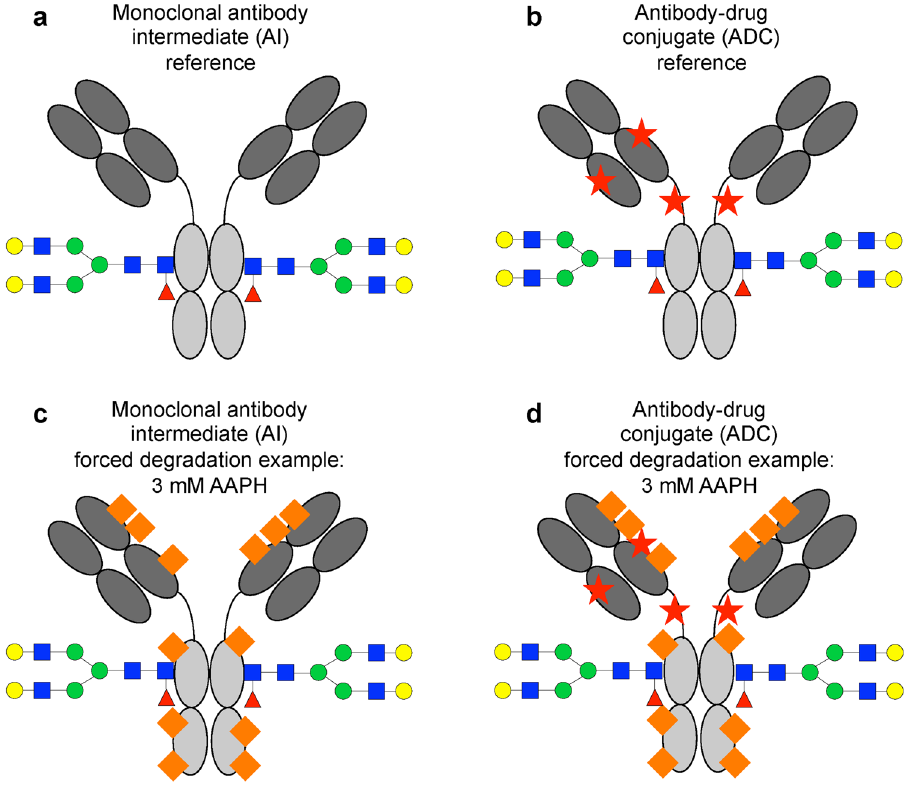
Figure 1. Overall experimental design. ( a ) Schematic representation of a reference antibody intermediate (AI) sample (gray), and its modifications such as N-linked glycosylation (colors). ( b ) Schematic representation of a reference antibody drug conjugate (ADC). The ADC is an immunoglobulin G1-kappa monomethylauristatin E (MMAE) conjugate, where one or more of the inter-chain disulfide bridges of the AI were intentionally chemically modified to an average of three to four linker-drug-modified cysteine residues (red stars). The conjugation was not expected to impact post-translational modifications of the AI. More than 34 post- translational modifications were considered herein, and enriched minor variant samples were generated for some modifications. ( c ) Schematic representation of one of the forced degradation conditions (e.g., 3 mM AAPH) applied to AI. The forced degradation introduces modifications such as oxidation (orange rectangles). ( d ) Schematic representation of one of the forced degradation conditions (e.g., 3 mM AAPH) applied to ADC. As in AI, forced degradation introduces modifications such as oxidation (orange rectangles). The Fab (dark gray) and Fc (light gray) regions of the molecules are shown for